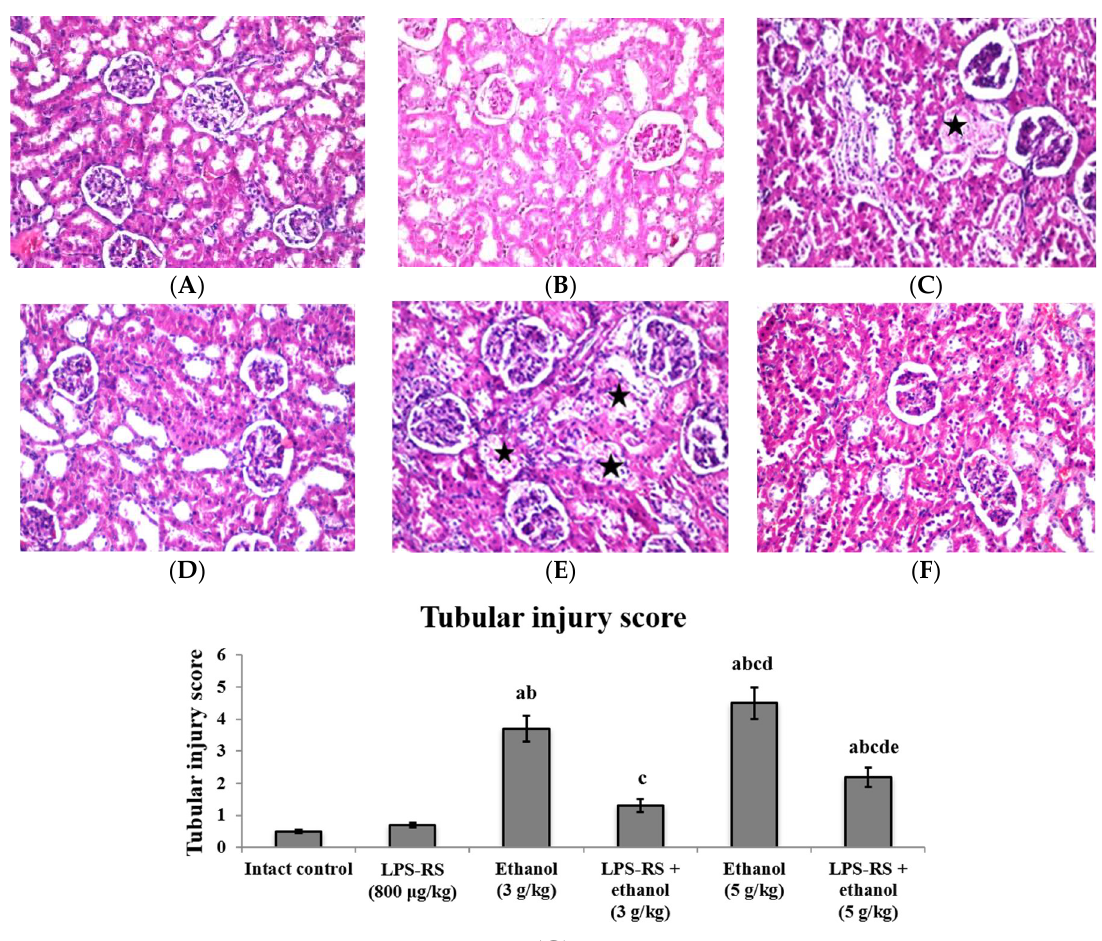
Figure 7. Histopathological sections of rats’ kidney stained with hematoxylin and eosin (H&E) (40×). ( A ) intact control group and ( B ) LPS-RS group; showing intact superficial layer, normal population and orientation of nephrocytes, ( C ) rats receiving ethanol (3 g/kg); showing coagulative necrosis (black star) in the lining epithelium of some individual tubules at the cortex, ( D ) LPS-RS + ethanol (3 g/kg) group; showing normal histopathological structure in kidney tissue, ( E ) rats receiving ethanol (5 g/kg); showing coagulative necrosis (black stars) in the lining epithelial cells of some individual tubules, ( F ) LPS-RS + ethanol (5 g/kg) group; showing almost normal histopathological structure, ( G ) Tubular injury score. The score is represented as mean ± SD and analyzed using one-way ANOVA followed by Bonferroni’s post-hoc test ( n = 8–10). Differences were considered significantly different at p < 0.05. a vs. intact control; b vs. LPS-RS; c vs. ethanol (3 g/kg); d vs. LPS-RS + ethanol (3 g/kg); e vs. ethanol (5 g/kg).